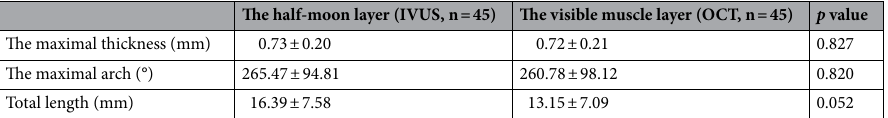
Table 2. Respective characteristics of the visual signs about MB detected by IVUS and OCT. Data were expressed as mean ± SD.